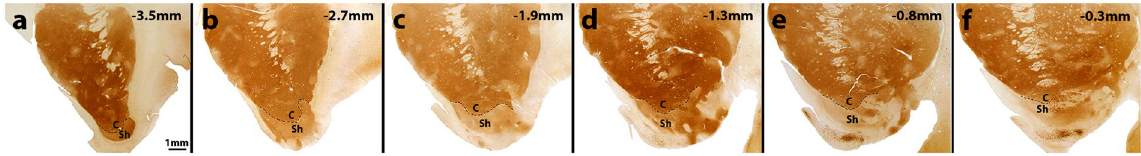
Figure 2. Photomicrographs of calbindin-stained coronal sections of basal forebrain across the rostrocaudal axis. ( a – f ) The first rostral section of the NAc was taken at approximately 3.5 mm anterior to the anterior commissure (AC) and the last caudal section was taken 0.3 mm anterior to the AC. The total length of the NAc was approximately 4 mm. Each slice distance relative to the AC is designated in the top right corner. The calbindin stain indicates the core and shell border of the NAc by overlaid dashed lines. The demarcation of core and shell is based on our own observation and previously published work 39,40 . Scale bar = 1 mm. C = core; Sh = shell.